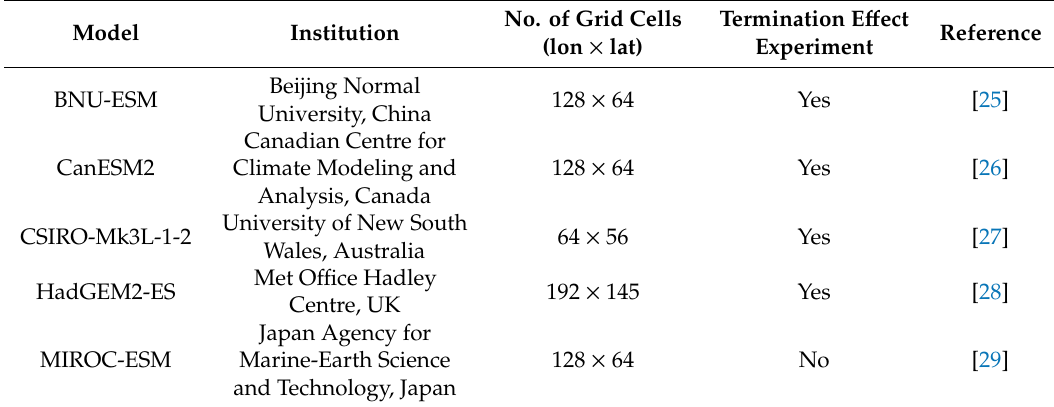
Table 1. Description of earth system models of the GeoMIP G4cdnc experiment used in this study. No. of Grid Model Institution